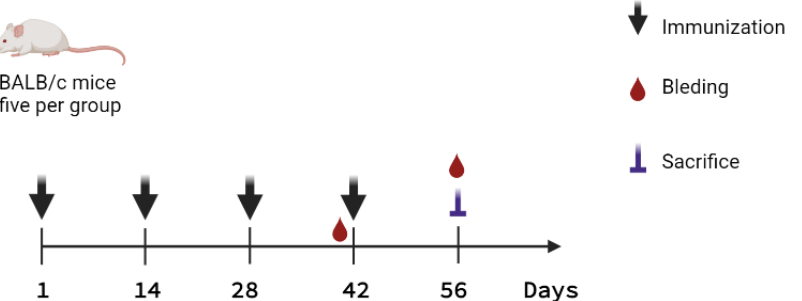
Figure 2. Immunization scheme to characterize the algae-made RBD. Mice were immunized by either oral or subcutaneous route on days 1, 14, 28, and 42 (denoted by the black arrows); and blood samples were withdrawn on days 41 and 56. Animals from PBS and C. RBD + CT p.o. groups were sacrificed until day 200 to determine long-lasting humoral responses. Table 1. Description of experimental groups. Mice were randomly assigned to the treatments described below.